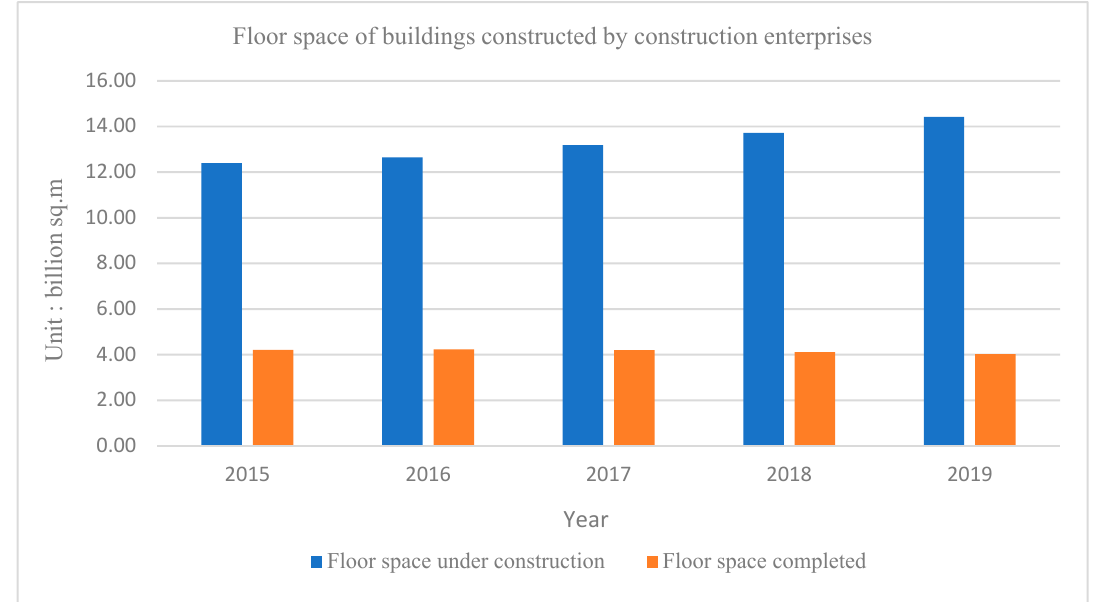
Figure 1. Floor space of buildings constructed by construction enterprises.